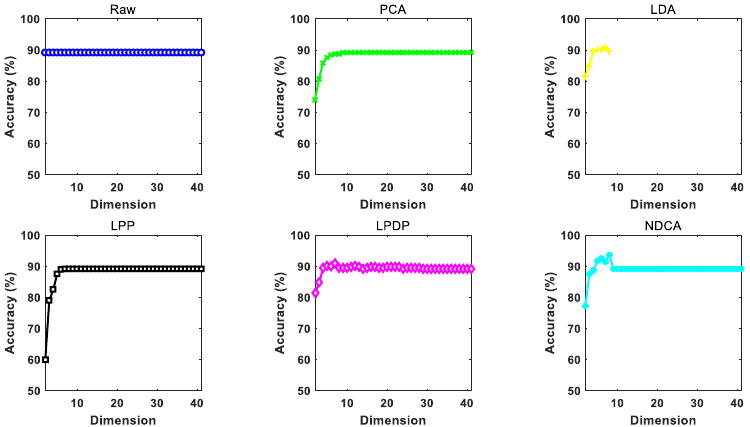
Figure 7. The performance of different dimension reduction methods under different reduced dimensions using NN as the classifier.